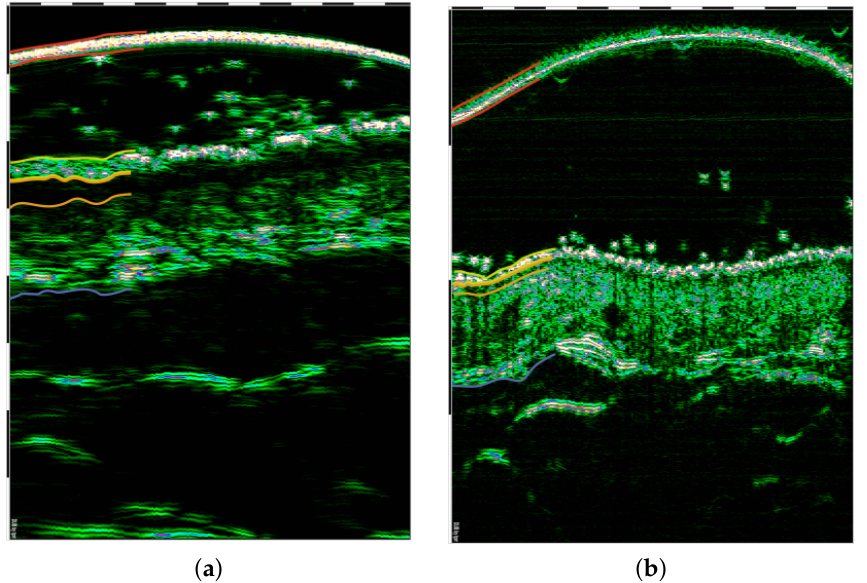
A comparison of the skin images acquired using a DUB SkinnScanner75, tpm (Lueneb- The colored lines partially delineate the most critical areas in the images. The red lines indicate the probe membrane, which is often visible in HFUS images; the yellow lines delineate the entry echo layer; the orange lines delineate the SLEB; and the blue lines are placed at the lower dermis edge.